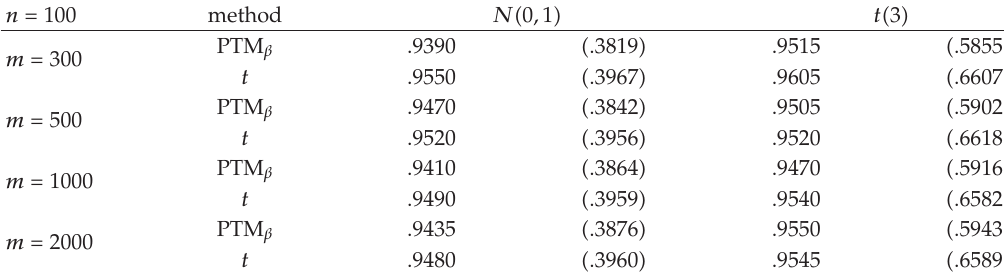
Table 1: Average coverage (cid:2) length (cid:3) of 95% CI’s by t and PTM β